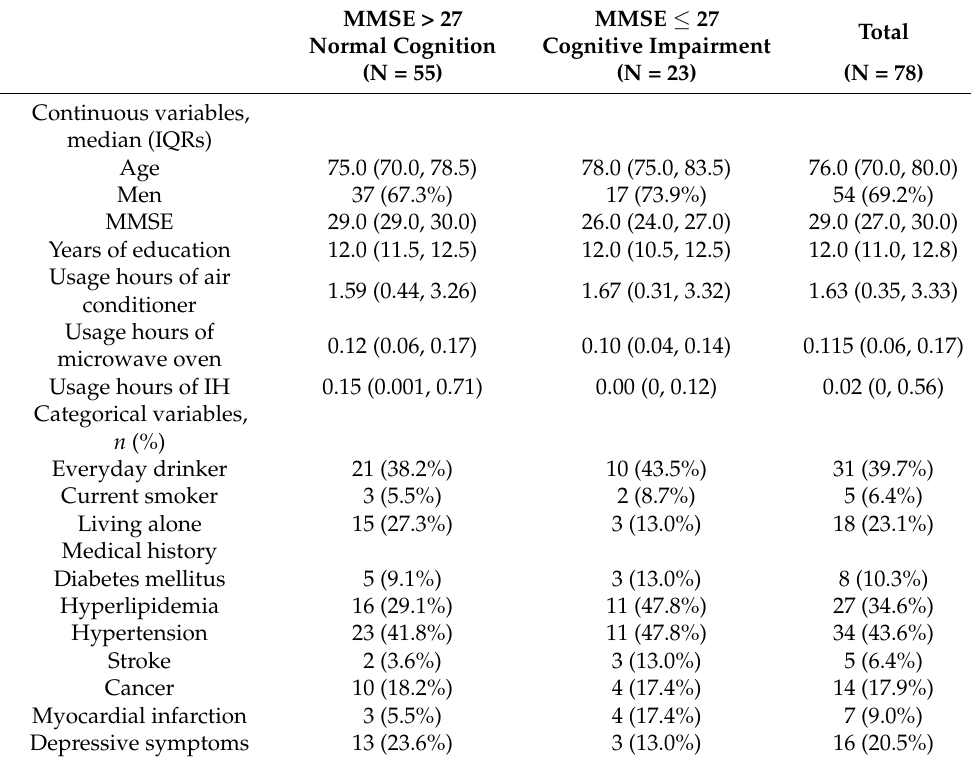
Table 1. Participant baseline demographics and clinical